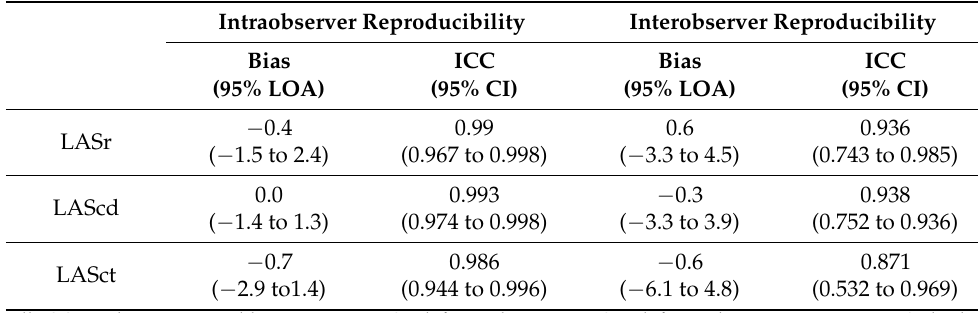
Table 4. Intraobserver and interobserver reproducibility of LAS measurements.